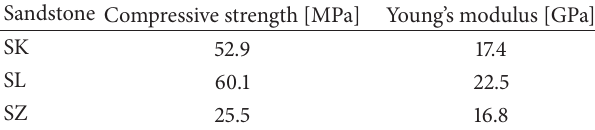
Table 5: Mechanical properties.